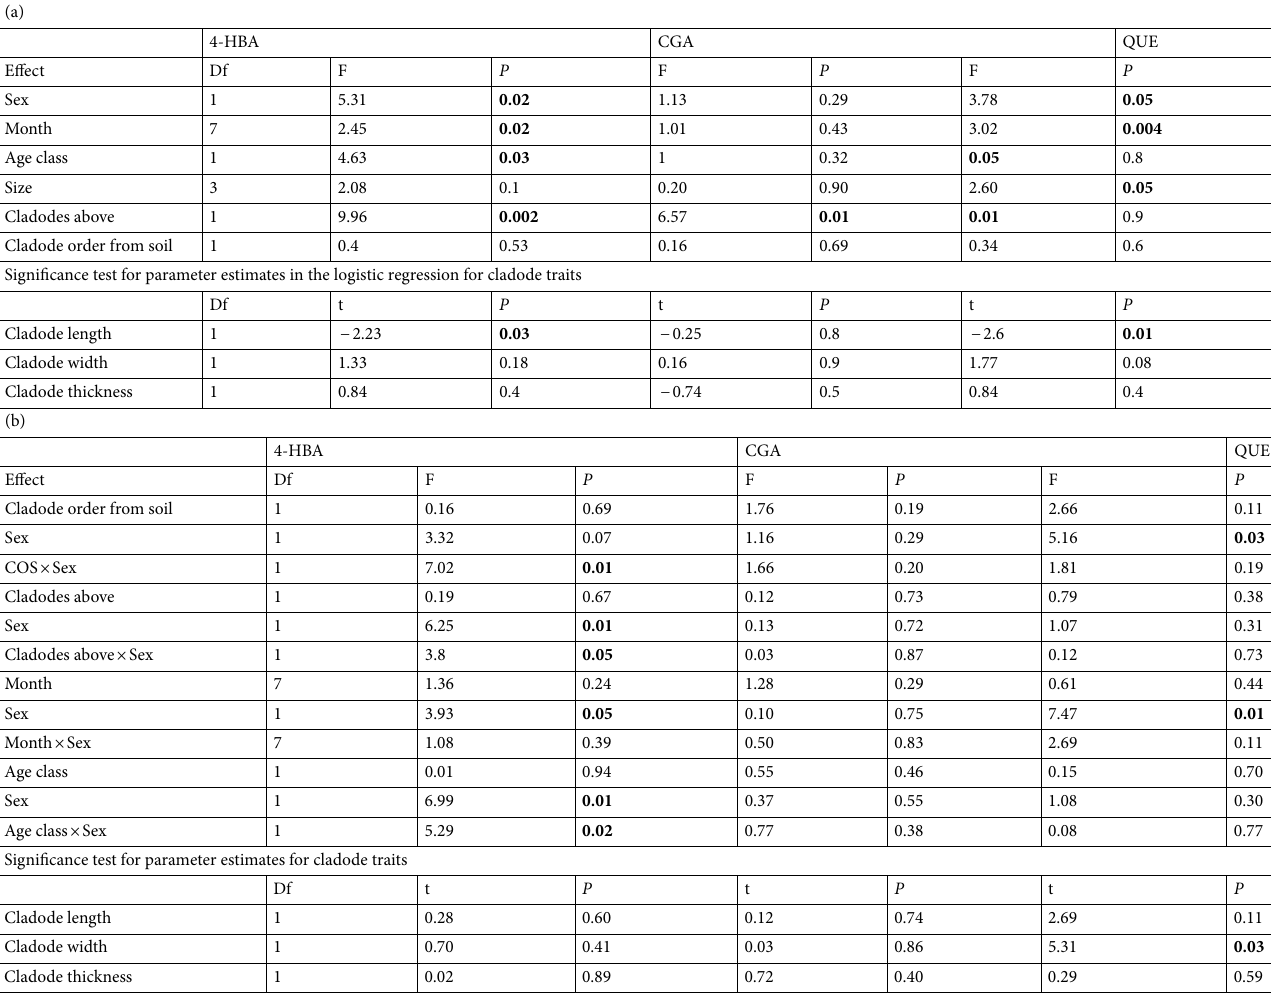
Table 1. Effects of sexual form (female, hermaphrodite), sampling month, cladode age class, cladode size (length, width, and thickness), number of cladodes above a given cladode, and order of cladodes above the soil, on the detection probability ( a ) and concentration ( b ) of 4-hydroxybenzoic acid (4-HBA), chlorogenic acid (CGA), and quercetin (QUE) for Opuntia robusta in central Mexico. The three estimators of cladode size (length, width, and thickness) were considered jointly in the type III test of the fixed effect for the probability of detection. Then, their effects were examined separately, and significance tests were performed, in the logistic regression model; df—the number of degrees of freedom in the model. We fitted four different models for the concentrations of each metabolite, for cladode order from the soil (COS), cladodes above a given cladode, month, and age. The values of P for effects significant at P ≤ 0.05 are marked with bold